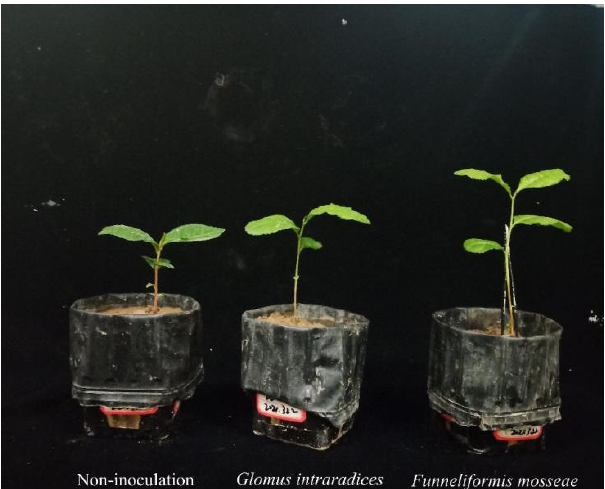
Figure 2. Plant growth performance of Camellia oleifera seedlings after two months of the inoculation with Funneliformis mosseae and Glomus intraradices (unpublished data by the authors).